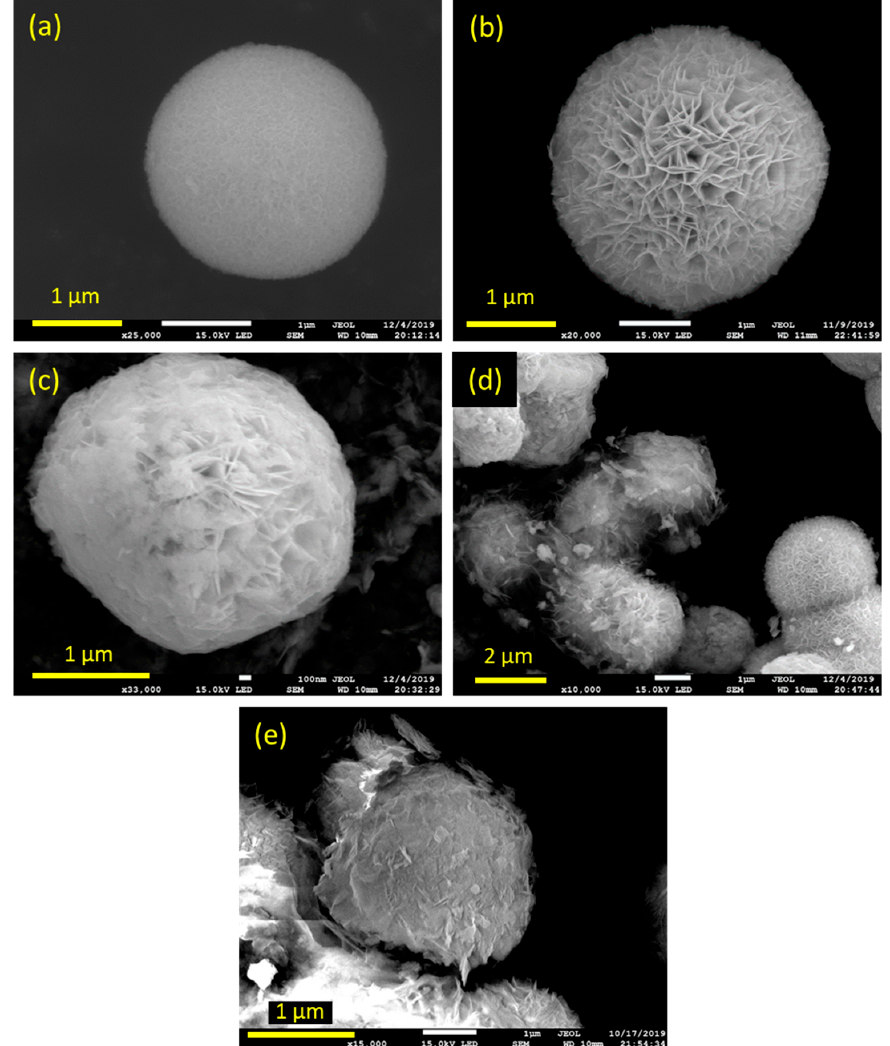
Figure A1. SEM images of BOC samples prepared after ( a ) 3, ( b ) 6, ( c ) 9, ( d ) 12, and ( e ) 18 h of solvothermal reaction time.